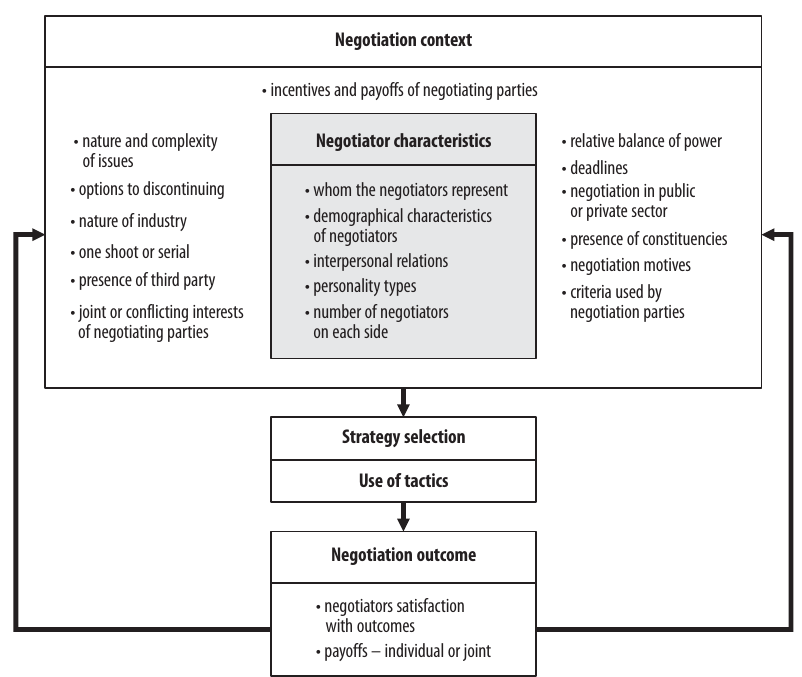
Figure 1. Areas of negotiation research in social